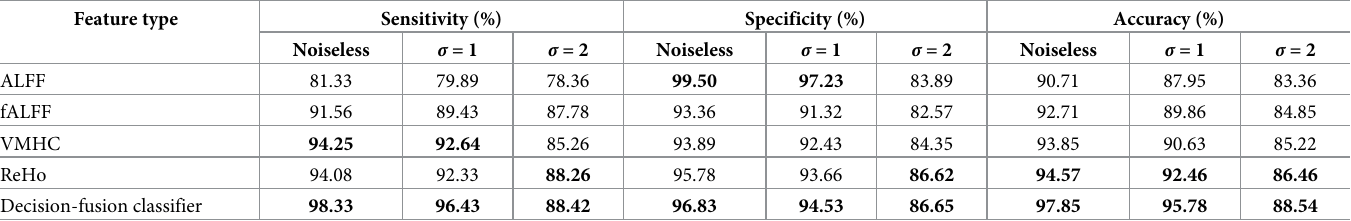
Table 8. Effects of Rician noise on schizophrenia detection performance with single-feature-type and decision-level fusion schemes for fMRI data contaminated with Rician noise levels of σ = 1 and σ = 2.